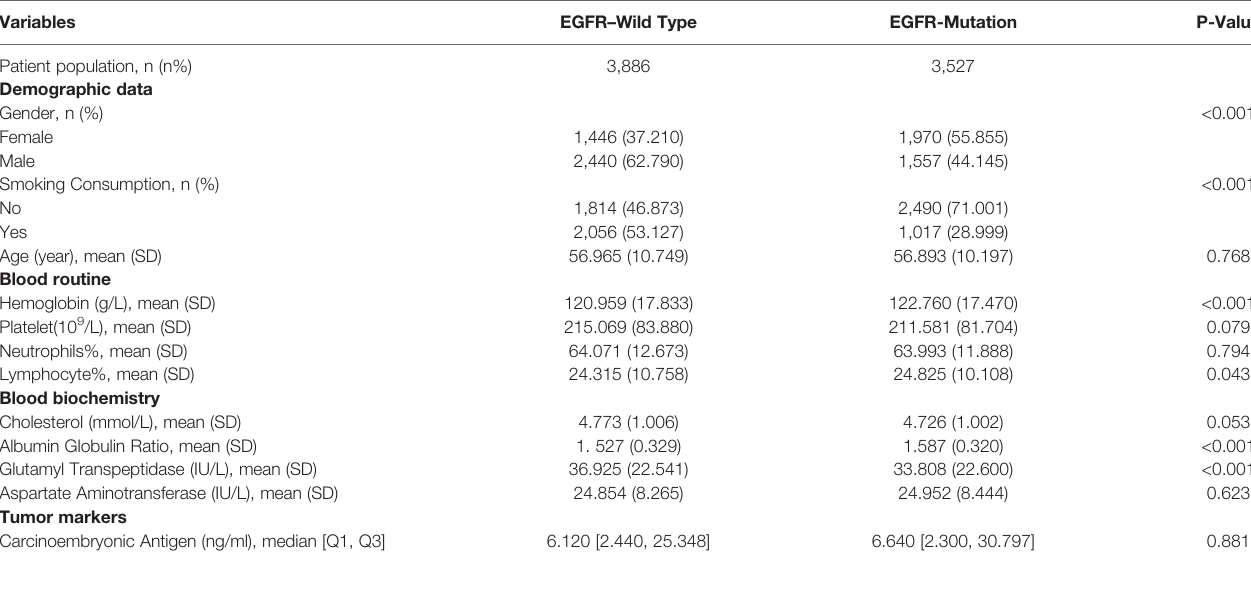
TABLE 1 | Patient characteristics and blood markers.